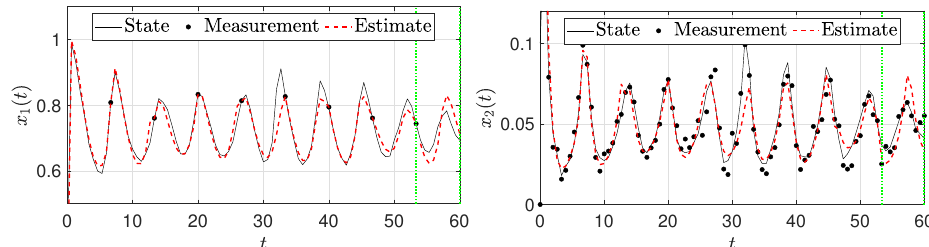
Figure 2. State estimation for exothermic reactor for t = 60: Accurate reconstruction in face of stochastic process dynamics.